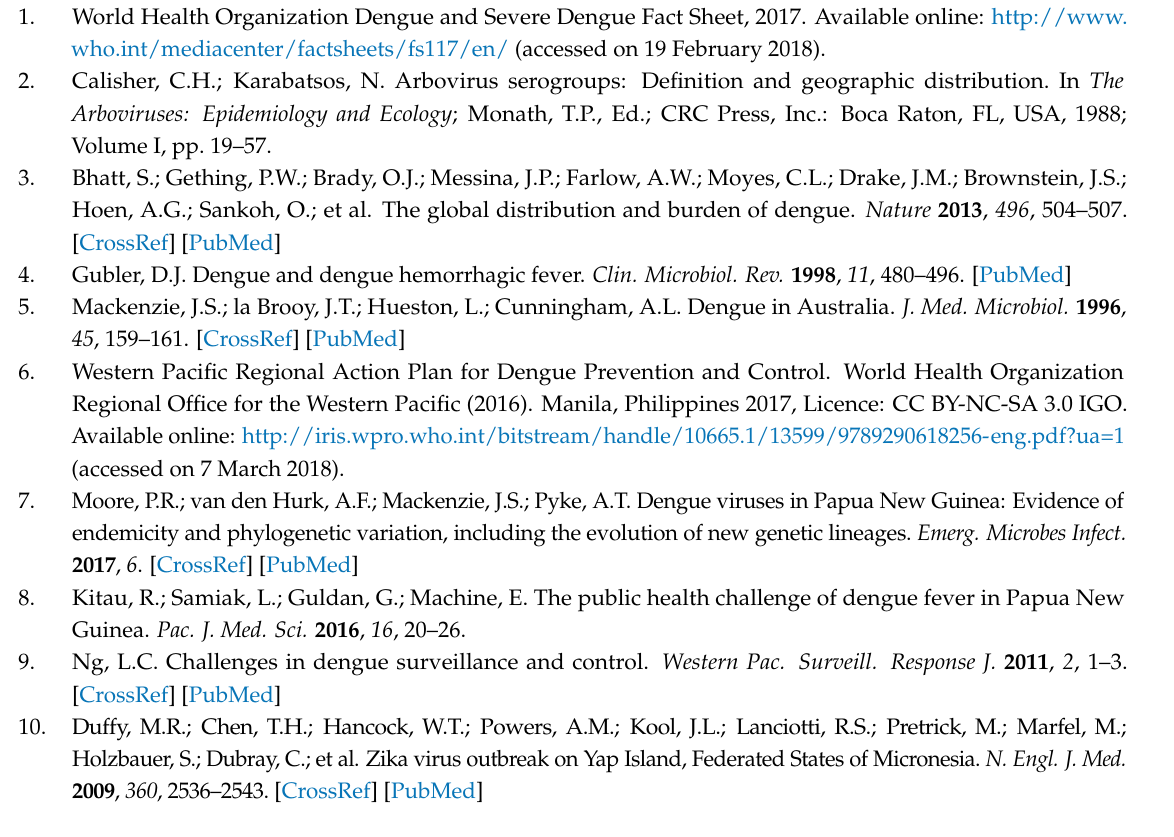
Figure S1. Testing algorithms for acute DENV infections performed by PHV. Figure S2. RT-rtPCR-positives reported by PHV for CHIKV (2008-2017) and ZIKV (2014-2017). Figure S3. Number of CHIKV isolates obtained, PHV, 2008-2017. Figure S4. Northern Queensland DENV outbreaks, 1990-2017. Table S1. Oligonucleotide primer and probe sequences and viral gene target regions for PHV pan-DENV, DENV 1-4, CHIKV and ZIKV RT-rtPCR assays. Table S2. The number of notified DENV 1-4, CHIKV and ZIKV cases reported in NZ for the period 2008-2017 by location (region travelled from or